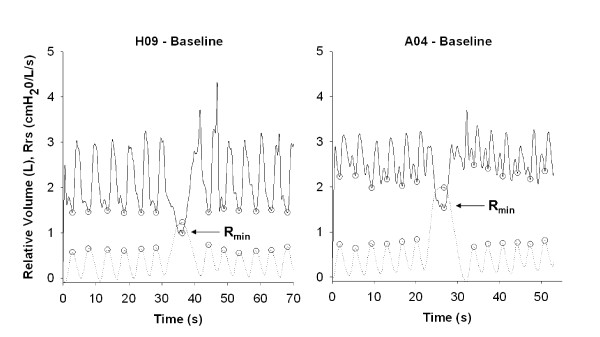
Typical respiratory system resistance tracings for a nonasthmatic and an asthmatic subject. Typical trace of respiratory system resistance (Rrs) at 8 Hz and relative inhaled volume (above functional residual volume) for a nonasthmatic (H09) and asthmatic (A04) subject at baseline. Both participants are female and of similar age, height, and weight. End-inspiration Rrs values are used in analysis (open circles). The minimum resistance achieved at maximum inspiration is termed Rmin. The Rrs is plotted as a solid line, and the inhaled volume is plotted as a dotted line.